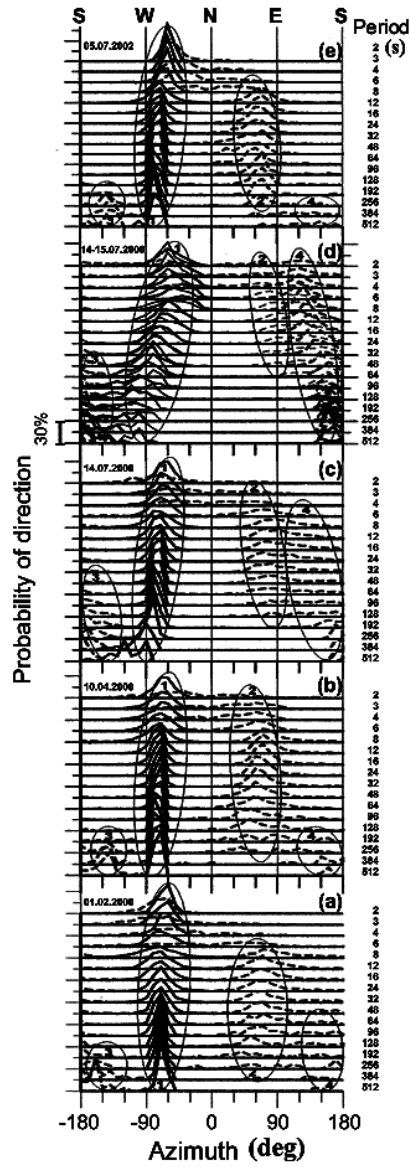
Figure 6. Temporal variation of the occurrence histogram of direction of arrival (azimuth) by means of the Izu array. The abscissa is the arrival azimuth (0: North, +, east and -, west). Time goes from the bottom (a) to the top (e); (a) February 1st, 2000 (4 months before the swarm), (b) Aprile 10, 2000 (two months before the swarm), (c) June 14, 2000 (12 days before the swarm), (d) July 14-15, 2000 (during the swarm) and (e) July 5, 2002 (two years after the swarm). There are 4 characteristic noise sources numbered from 1 to 4. The number 4 is the seismogenic